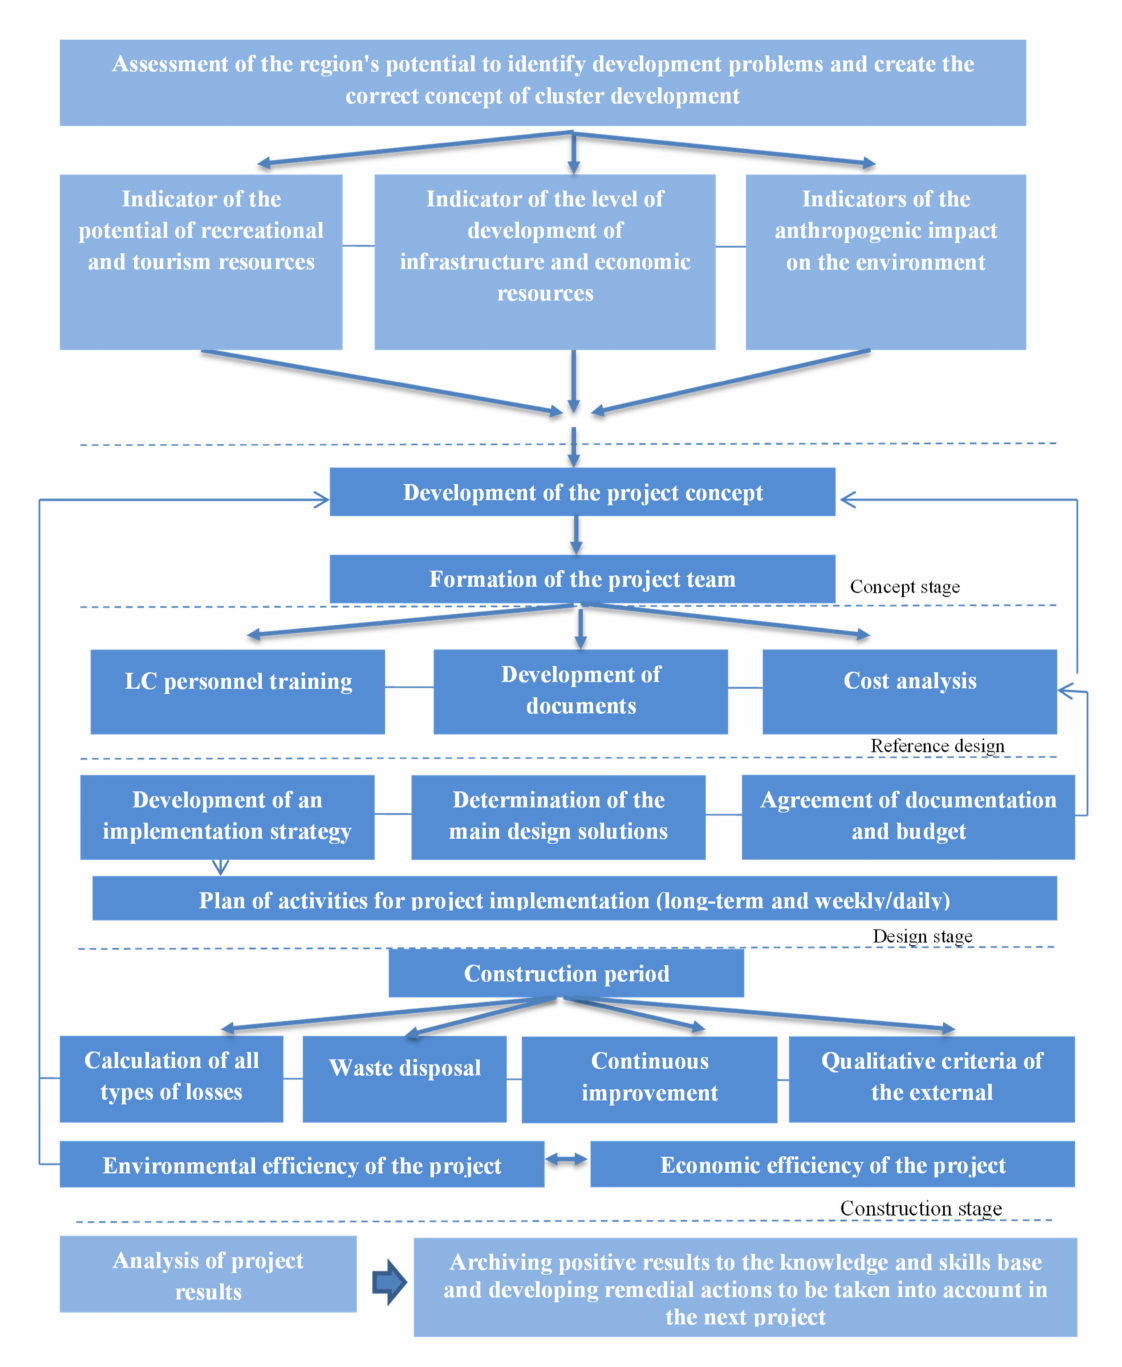
Figure 5. Improvement of development projects implementation based on lean